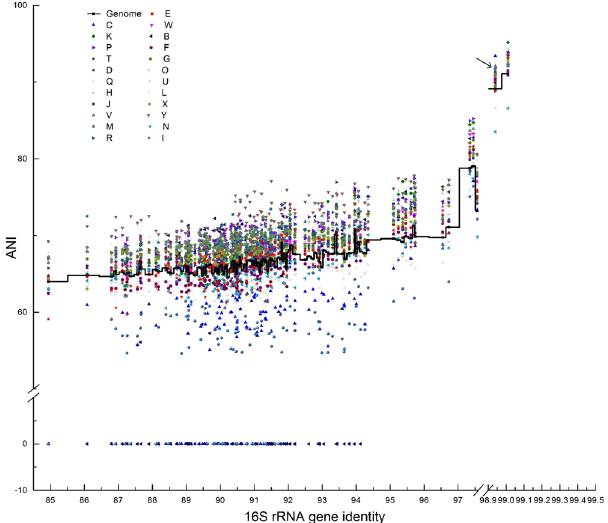
Figure 6. Relationships between 16S rRNA gene identity for all pairs of the reference genomes and the ANI of either the whole genome or the gene cluster (based on functional category); the arrow points to pairwise ANIs between strain MJ9-5 and MN12-7; pairwise comparisons with no hits were assigned as 0. Functional categories are: B, metabolism of aromatic compounds; C, iron acquisition and metabolism; D, dormancy and sporulation; E, carbohydrates; F, cell wall and capsule; G, DNA metabolism; H, potassium metabolism; I, phosphorus metabolism; J, regulation and cell signaling; K, nitrogen metabolism; L, protein metabolism; M, stress response; N, sulfur metabolism; O, fatty acids/lipids/isoprenoids; P, cell division and cell cycle; Q, membrane transport; R, virulence/disease/defense; S, miscellaneous; T, cofactors/vitamins/prosthetic groups/pigments; U, nucleosides and nucleotides; V, RNA metabolism; W, amino acids and derivatives; X, respiration and Y, secondary metabolism. The environmental impacts in two Arcticibacter strains including sixteen Sphingobacteriaceae